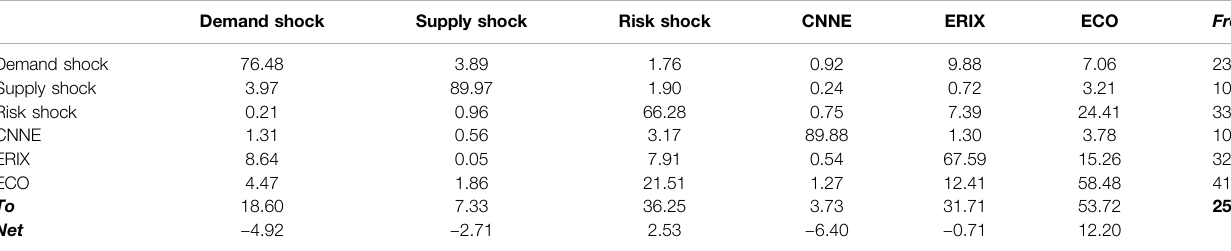
TABLE 3 | The connectedness matrix for crude oil price shocks and new energy